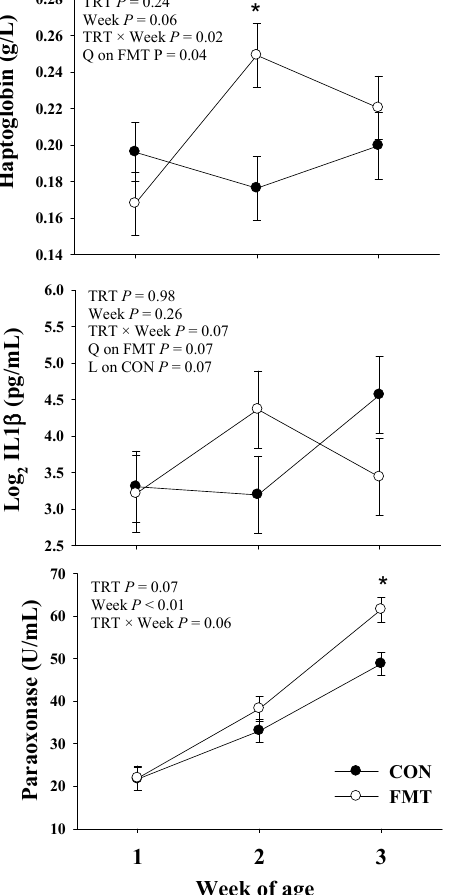
Figure 4. Inflammatory (Haptoglobin and interleukin 1 beta [IL1- β ]) and liver function biomarkers (paraoxonase) during the neonatal period in Holstein dairy calves raised under a conventional nutritional program (CON) or subjected to fecal microbiota transplantation (FMT). The p -values for main effects of treatment (TRT) and week, and their interaction (TRT × Week) are shown in each plot. The TRT × Week effect ( p ≤ 0.10) were further analyzed through orthogonal contrast in order to determine linear (L) and quadratic (Q) effects. A significant difference ( p < 0.05) between treatments in a specific time point was denoted by an asterisk (*). Values are means, with standard errors represented by vertical bars.